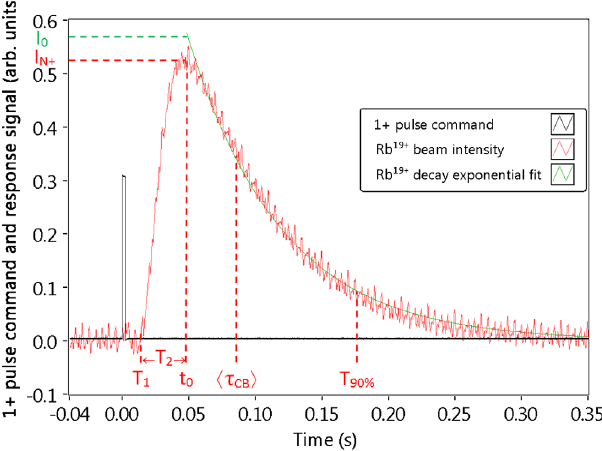
FIG. 4. Red: Rb 19 þ response to a 2.5 ms injected pulse and characteristic parameters (see text for details). Black: 1 þ in- jection pulse. Green: Exponential fit of the pulse decay.